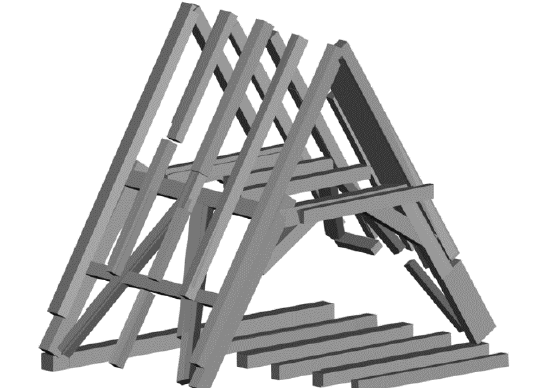
Figure 13: Automatically-reconstructed beams represented by their best fitting cuboids